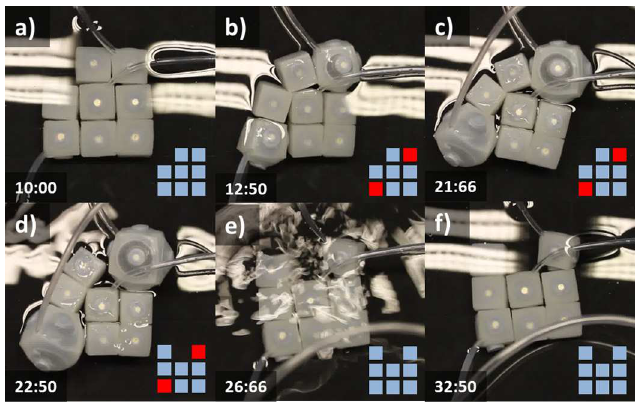
Fig 13. Self-Reconfiguration on setup 2A-6U. Demonstrationof self-reconfigurationon a small group of 8 modulessubmerged in water. Two diagonallyoppositemodulesinflate (b) producing the anti-clockwise rotationandtranslation of the upper-center module toward the left. At the same time the left most center module moves upsideright and rotates clockwiseresultingin a new inter-moduleattachment(c) and subsequent detachment (d). Finallya new stable squaredshapeemerges (e-f). Time stamps are in the format seconds: centiseconds.